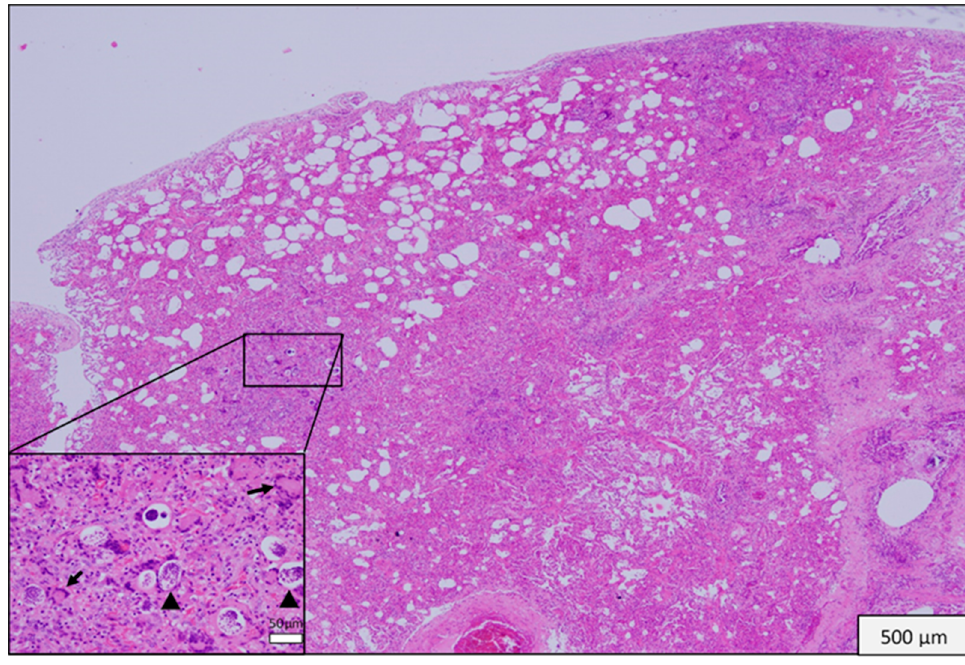
Figure 1. Mongoose 37. Lung. Multifocal granulomatous verminous pneumonia. (Inset) Granulomatous interstitial pneumonia with giant cells (arrows) and nematodes (arrow heads).